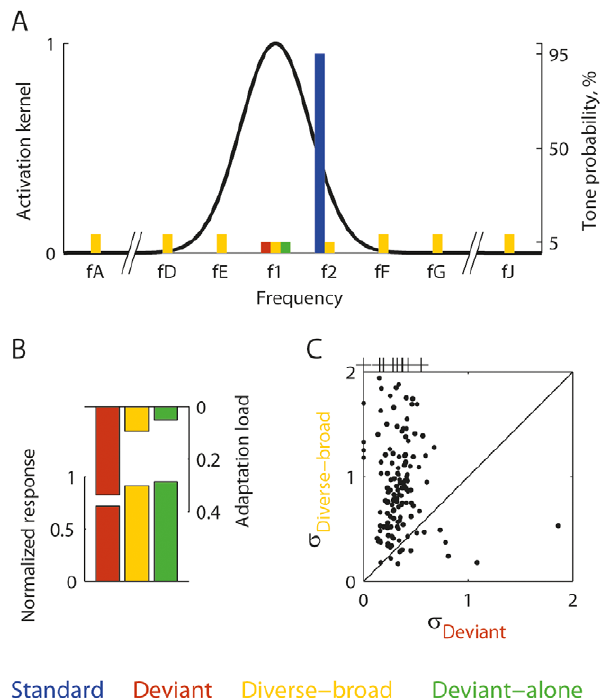
Figure 9. A simple adaptation model. A. A schematic plot of the adaptation channel centered on f o =f1 with s =0.34 (left ordinate) and three of the sequences that included this frequency with probability of 5% (right ordinate), all three with D f=44%. The Deviant f1 sequence (probability of f1 marked in red) included also tones at frequency f2 with a probability of 95% (blue). Frequency f2 lies within the effective range of the kernel centered on f1, thus causing a significant amount of adaptation. The Diverse-broad sequence includes f2 with probability of 5% and 10 other frequencies with a probability of 9% each (yellow). These additional frequencies are marked here fA to fJ (some of them are omitted from the figure due to space limitations). The Deviant-alone f1 sequence (green) does not contain any other frequency. The bars representing tone probabilities at f1 and f2 for the different sequences are shown side by side. B. Upper bars - the adaptation load for the three p f K f o , f conditions, P f